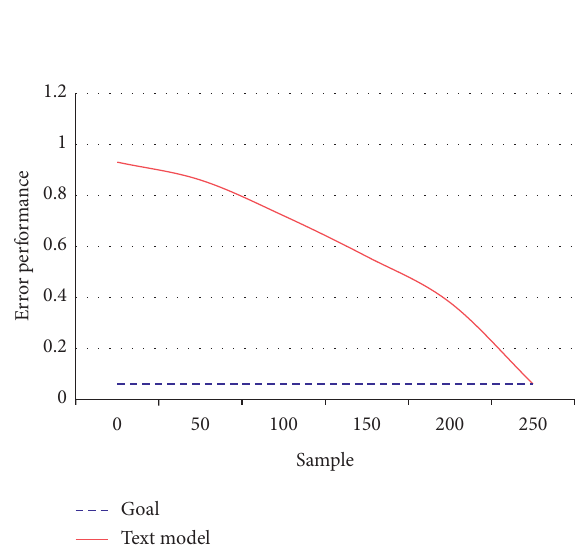
Figure 5: Error performance curve of the early warning model in this